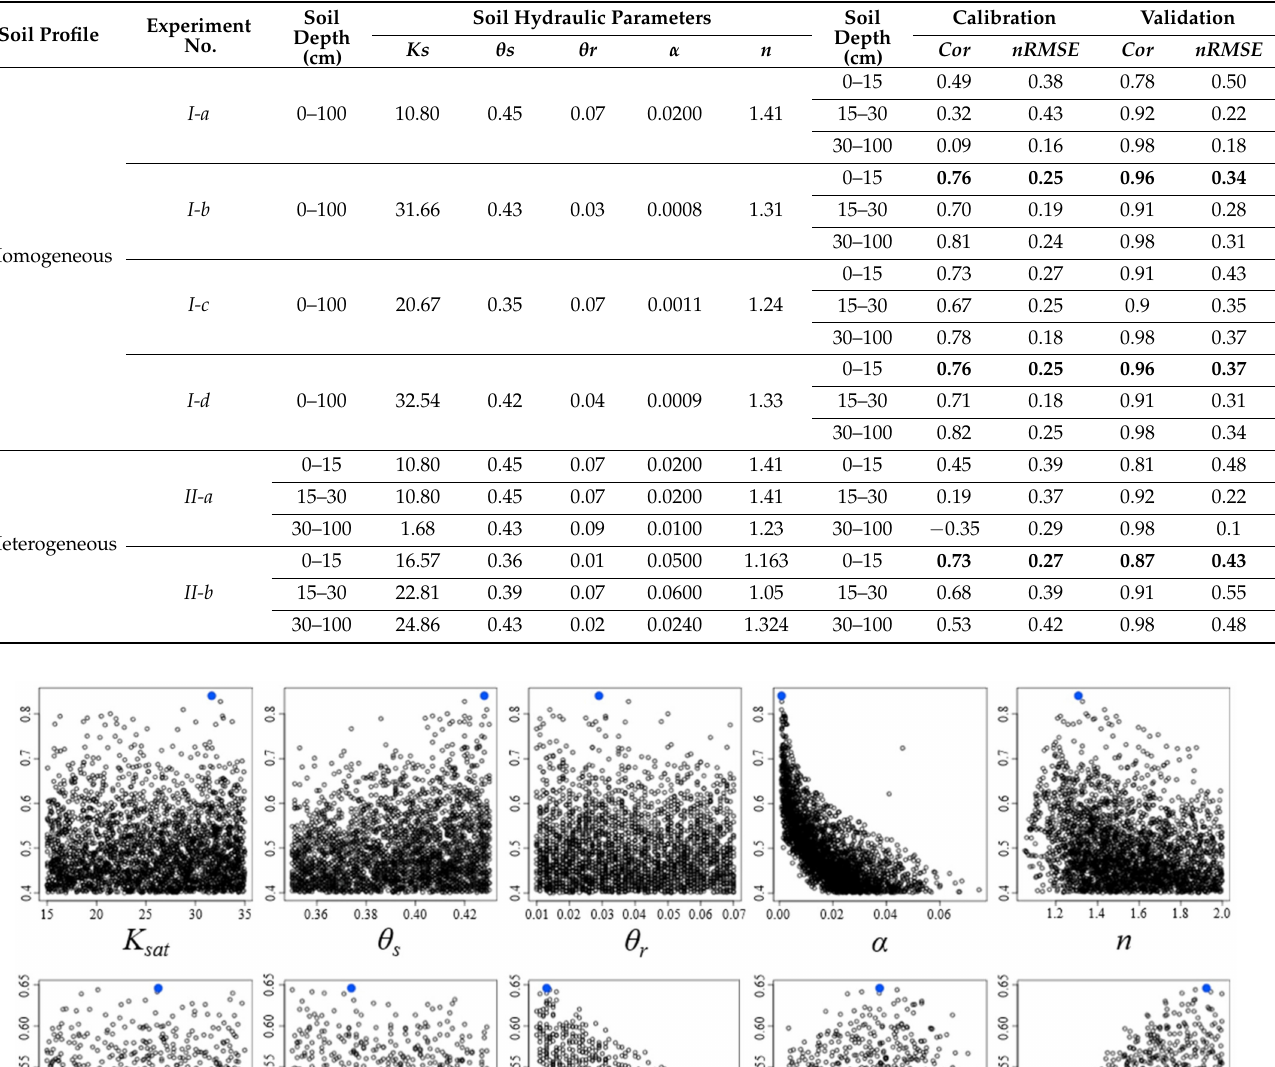
Table 3. Summary of the experiments, nature of the corresponding soil profile and soil depth, optimized SHPs, and correlation and nRMSE of output soil moisture from each experiment in calibration and validation period.